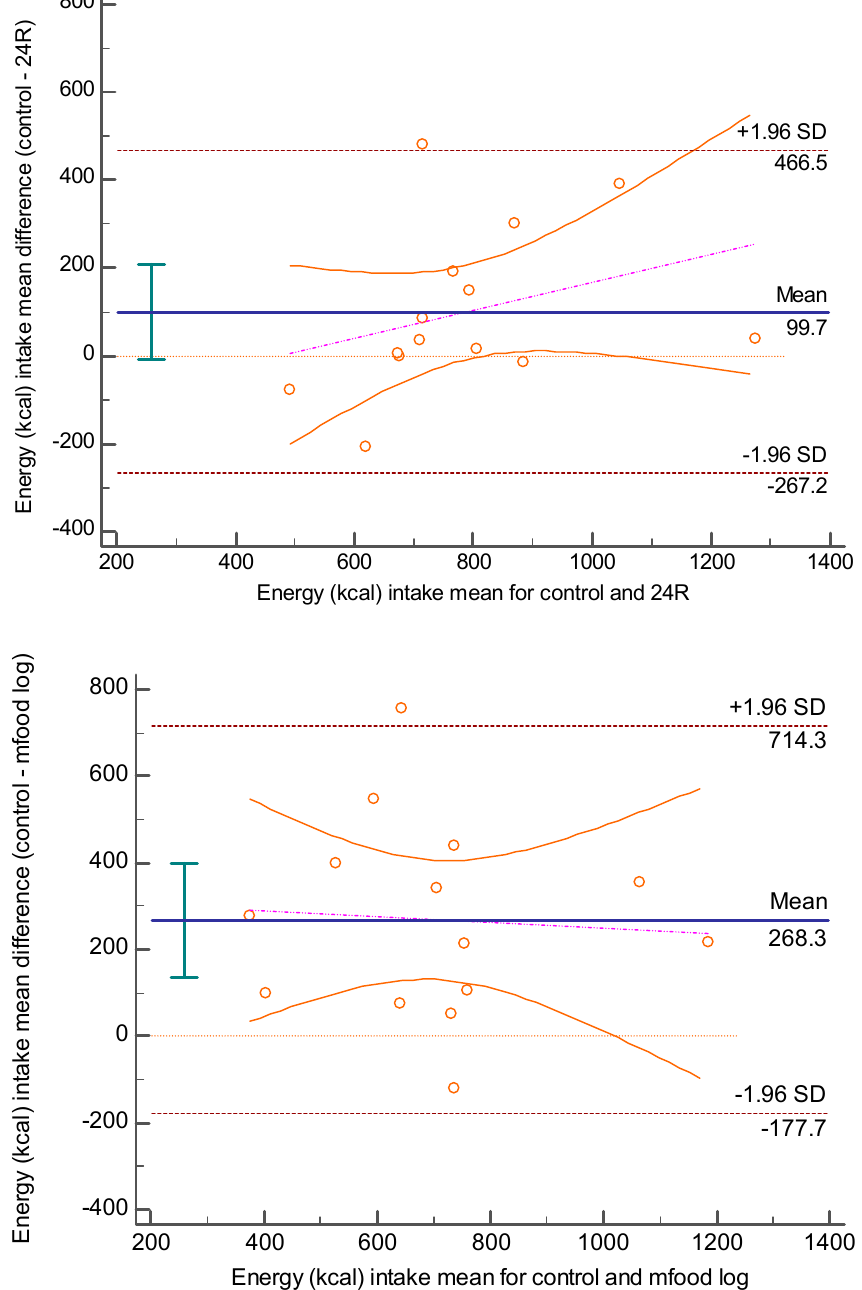
Figure 2. Bland Altman plot with regression lines for mfood log (control – mfood log) and 24R (control – 24R).